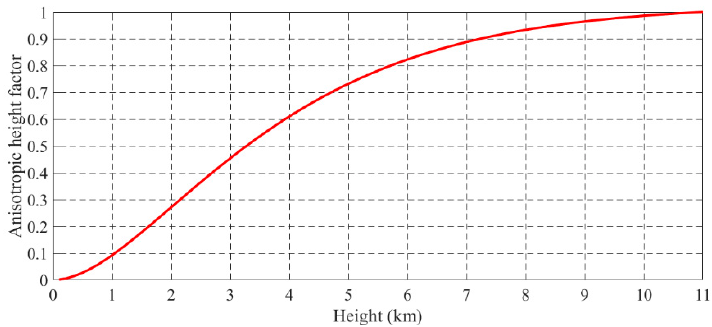
Figure 5. The anisotropic height factor changes with